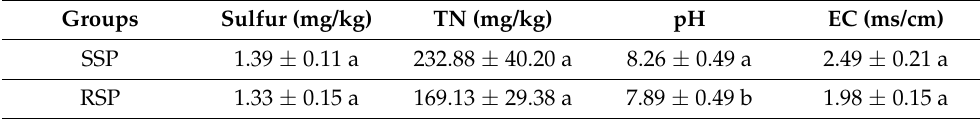
Table 1. Changes in soil physicochemical properties between the SSP and RSP groups.